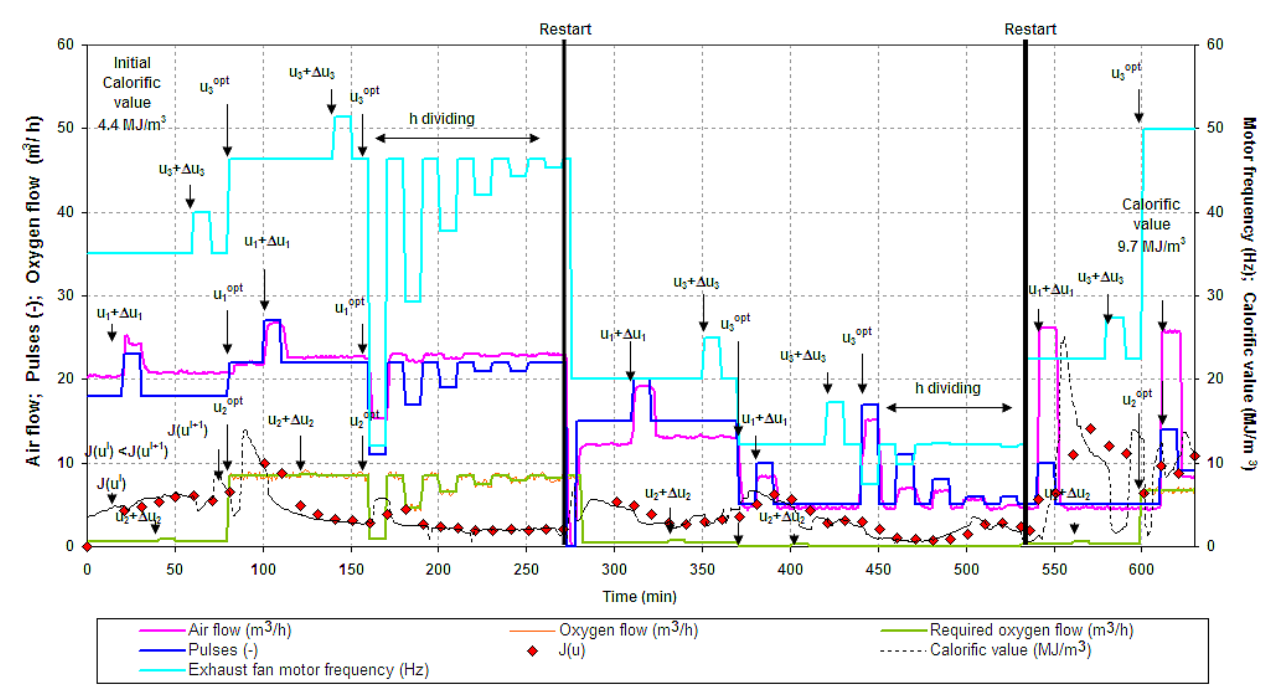
increasing the flow of oxygen, and reducing exhaust fan power. The automatic restart of Figure 11. The first test of optimal control with optimization of three parameters. the algorithm was not activated during the test. In the fourth test of optimal control, three parameters were also optimized, and the calorific value of syngas was maximized. Figure 12 shows the graph presentation of the optimization activity. The algorithm ran a total of 10 h, and the calorific value increased from an initial 4.4 to 8 MJ/m 3 . This result was reached by gradually reducing the airflow,